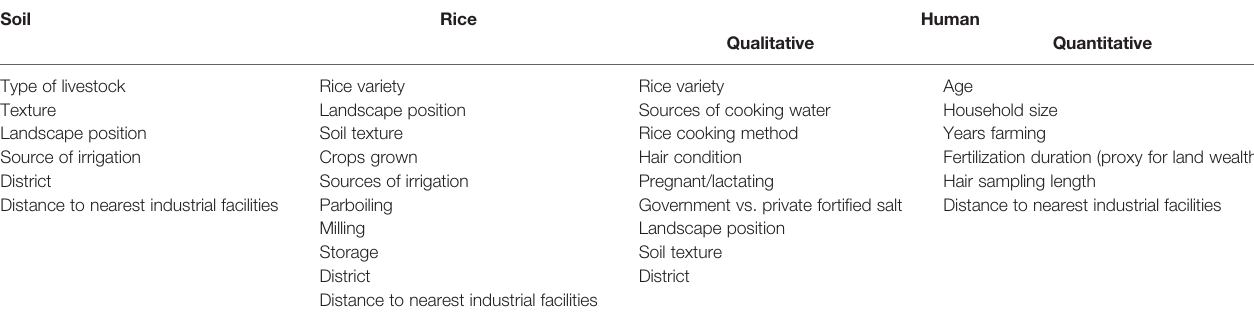
Age Household size Years farming Fertilization duration (proxy for land wealth) Hair sampling length Distance to nearest industrial facilities